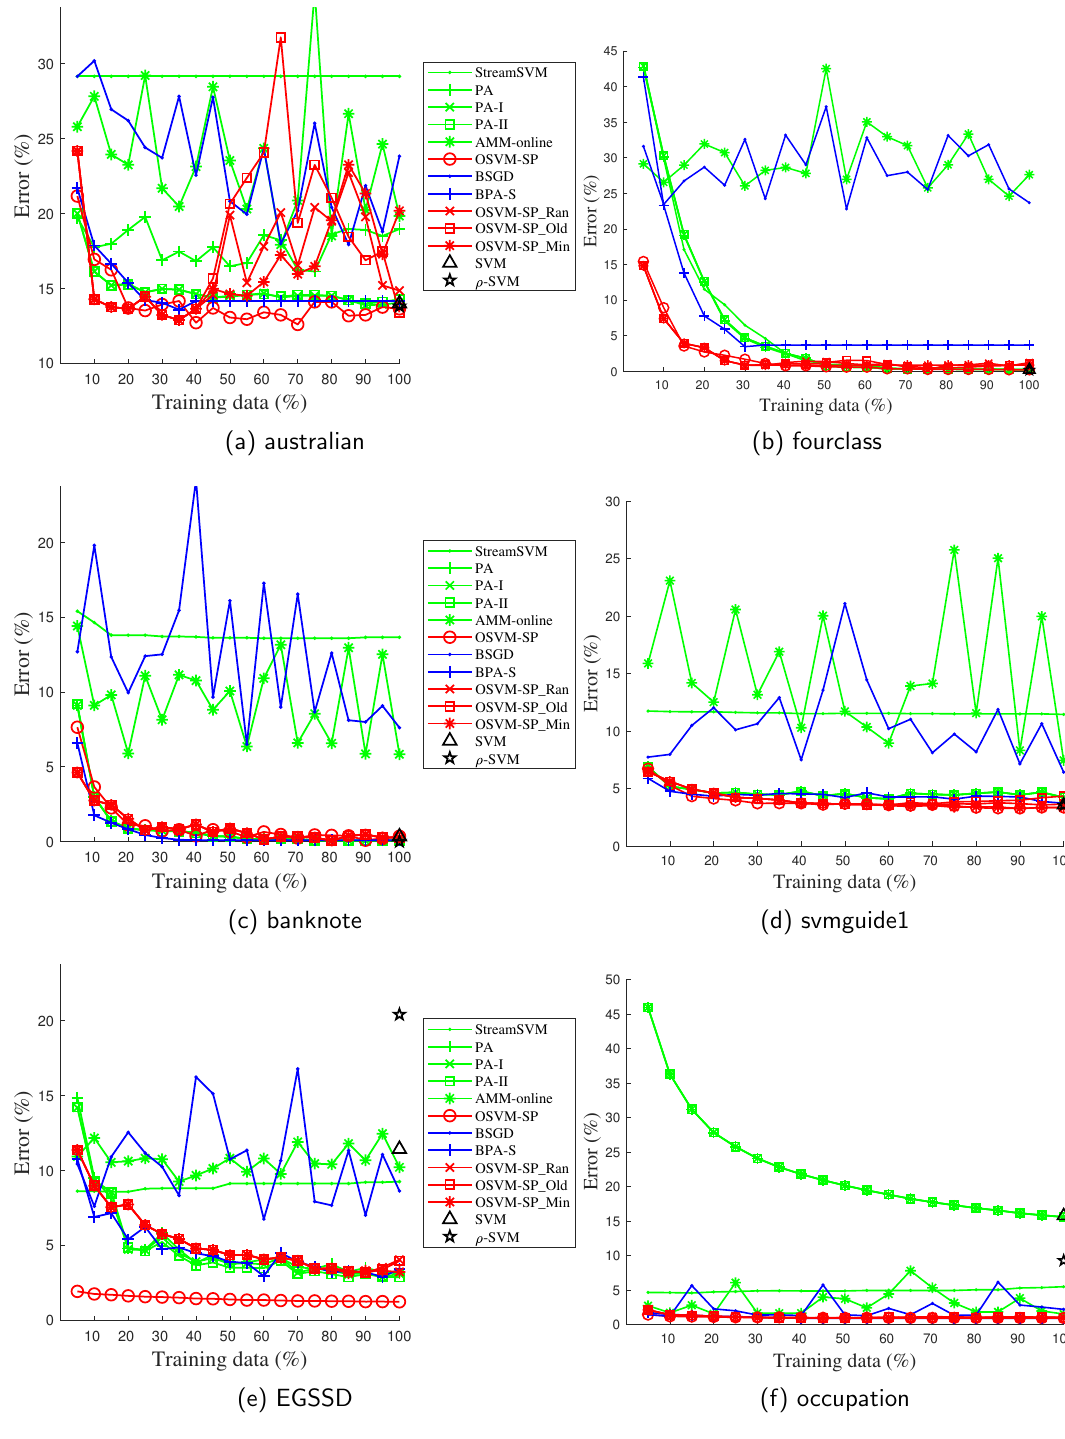
Fig. 6 Classification error with varying amounts of training data. Figure 6. Classification error with varying amounts of training